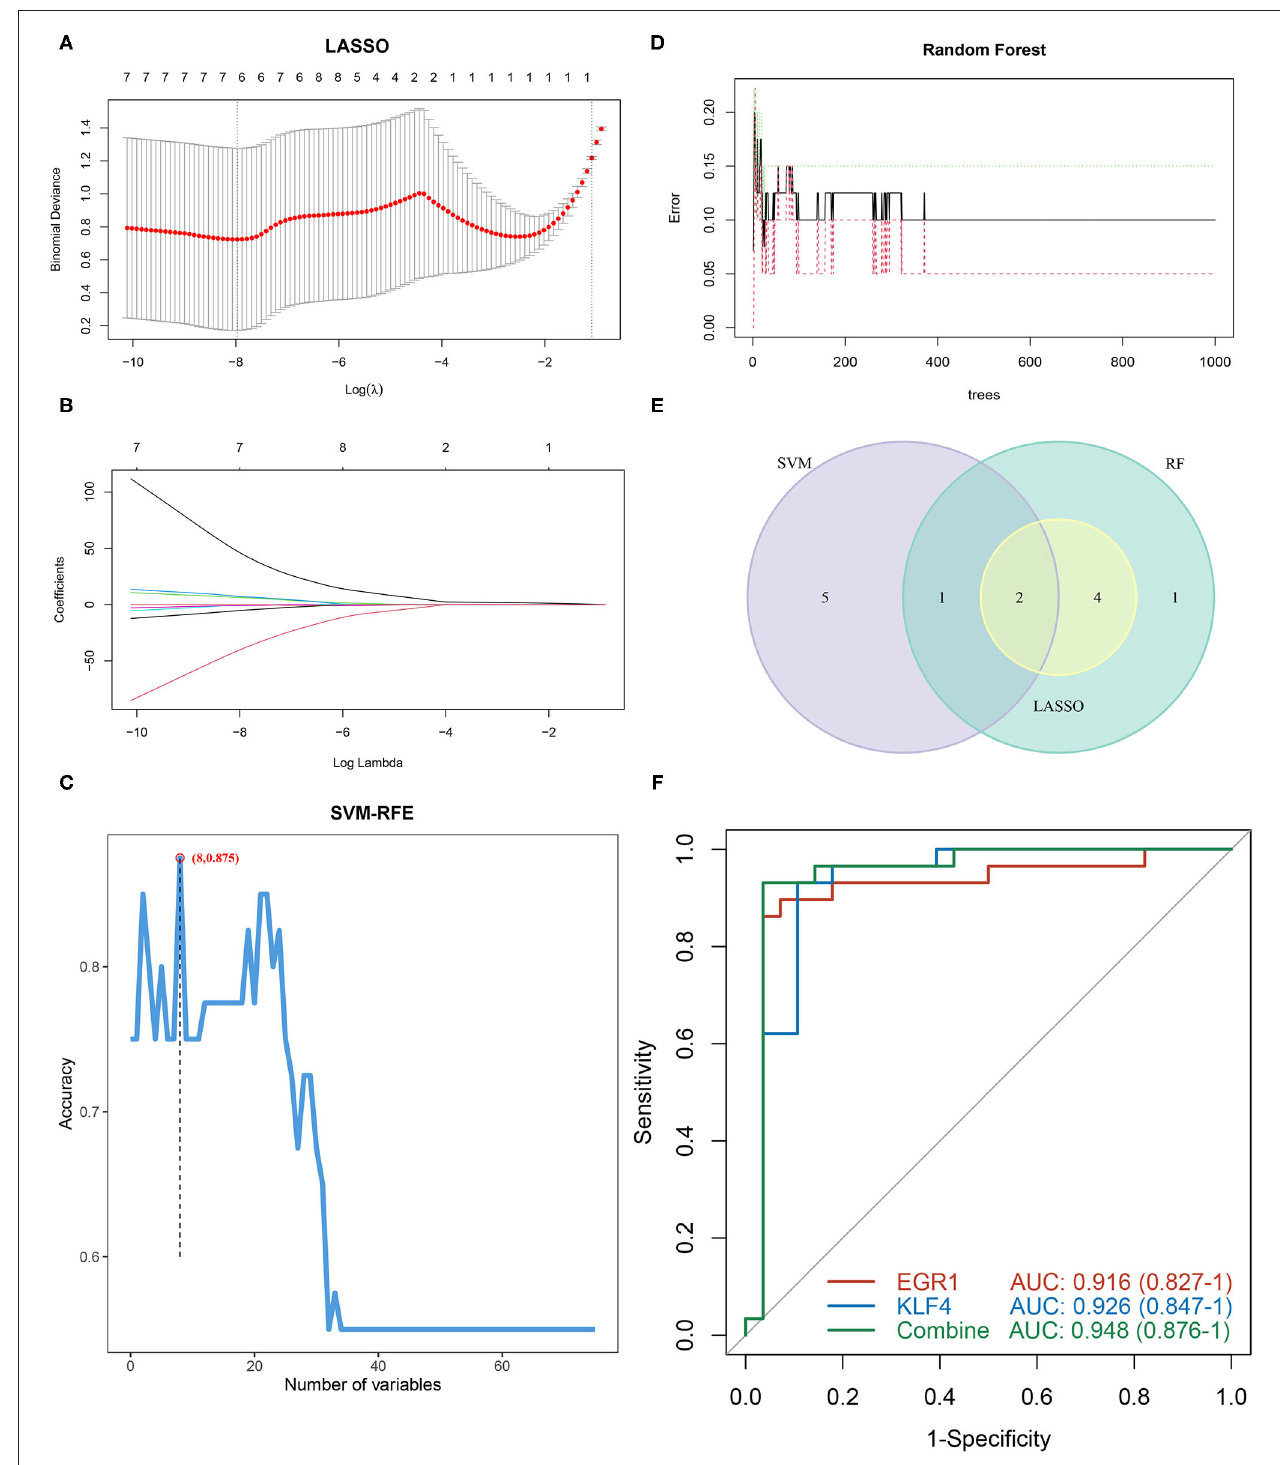
FIGURE 5 | Screening and verification of diagnostic markers based on machine learning. (A,B) LASSO logistic regression algorithm to screen diagnostic markers. (C) SVM-RFE algorithm to screen diagnostic markers. (D) RF algorithm to screen diagnostic markers. (E) Venn diagram shows the intersection of diagnostic markers obtained by the three algorithms. (F) The ROC curve of the diagnostic efficacy verification after fitting two diagnostic markers to one variable.